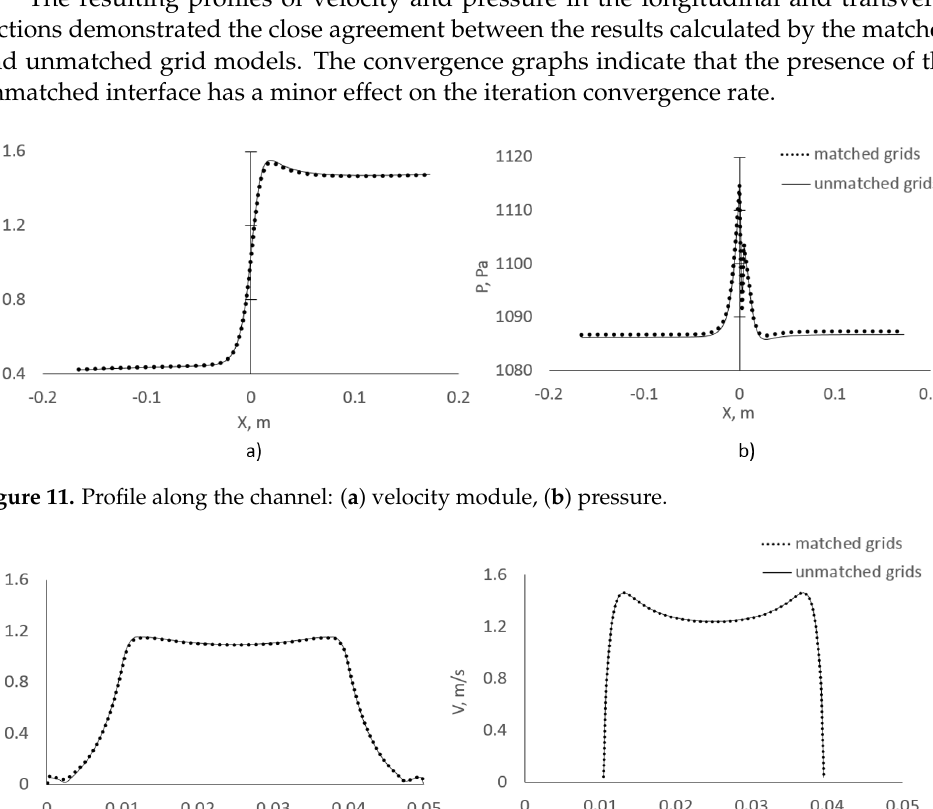
Figure 10. Convergence graph ( R is the mass discrepancy, N is the step number).